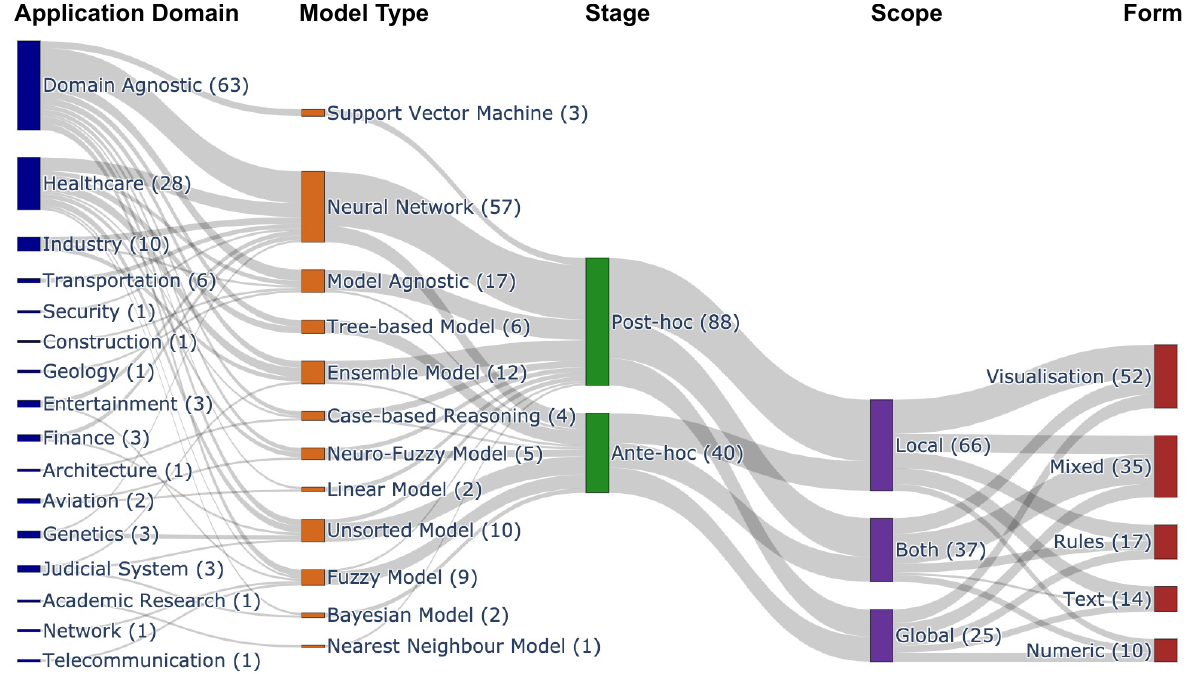
Figure 9. Number of the selected articles published from different application domains and clustered on the basis of AI/ML model type, stage, scope, and form of explanations. The number of articles with each of the properties is given in parentheses.